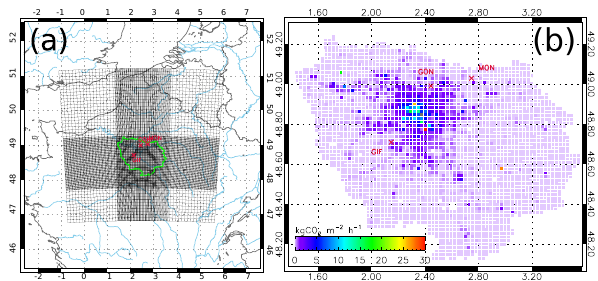
Figure 1. (a) Map of the northern France modelling domain with the monitoring sites (red crosses) and the boundary of the Île-de- France region (green line). Model grid (black lines): 2km × 2km spatial resolution in the centre, 2km × 10km and 10km × 10km spatial resolution in the surroundings. (b) Fossil fuel CO 2 emission for January 2011 for each grid cell of the Île-de-France region ac- cording to AIRPARIF